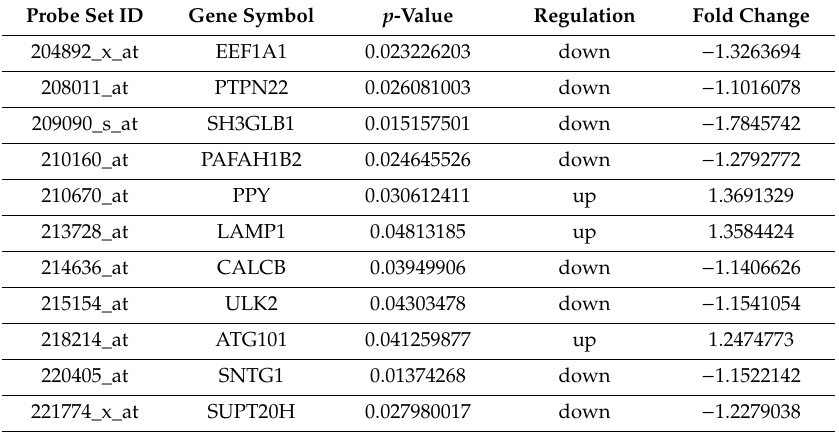
Table 2. Autophagy-related ID of miRNA differentiating control group (normal tissue) vs. research groups (cancer tissue). Determined with nonparametric t -test with Benjamini ‒ Hochberg adjustment.